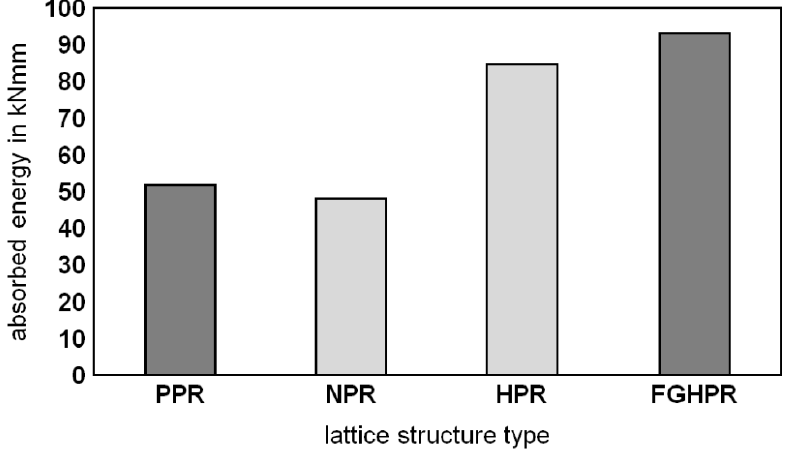
Figure 15. The absorbed energy of the PPR, NPR, HPR, and FGHPR lattice structures.